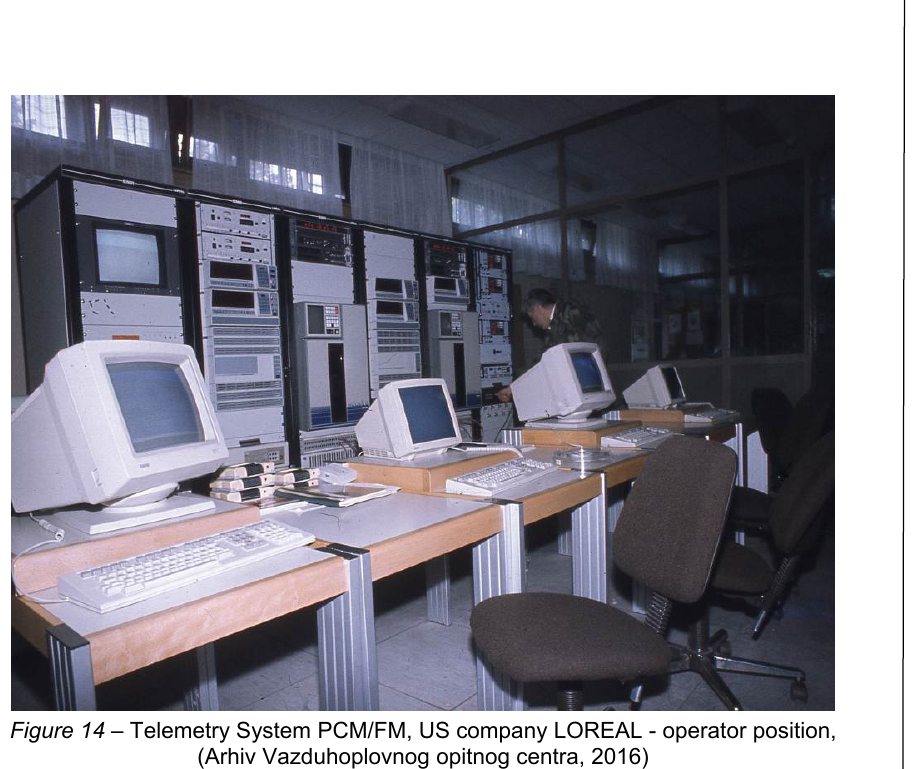
Figure 14 – Telemetry System PCM/FM, US company LOREAL - operator position, (Arhiv Vazduhoplovnog opitnog centra, 2016) Рисунок 14 – Телеметрическая система PCM/FM, американской компании "LOREAL" - рабочее место оператора (Arhiv Vazduhoplovnog opitnog centra, 2016) Слика 14 – Телеметријски систем PCM/FM, америчке фирме „LORAL” – позиције оператора (Arhiv Vazduhoplovnog opitnog centra,